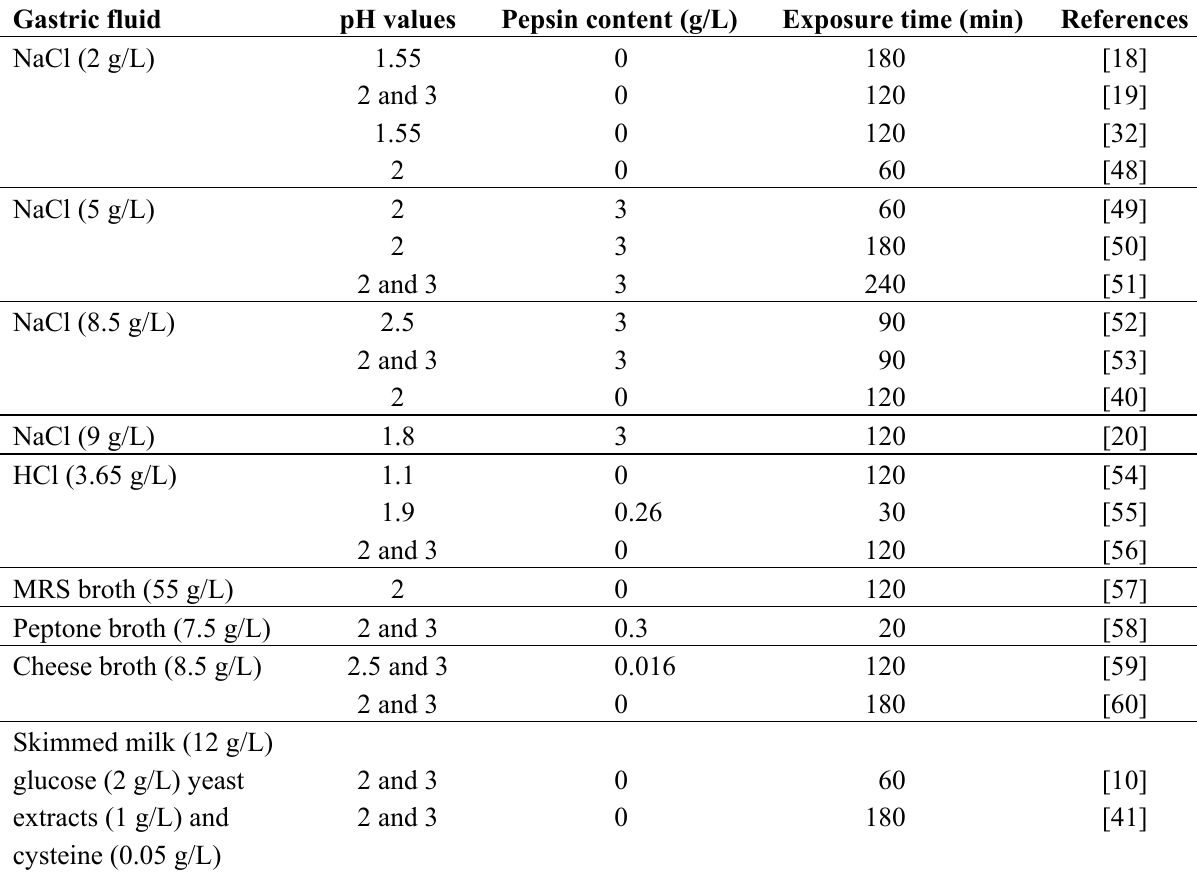
Table 1. In vitro conditions most often used to simulate the